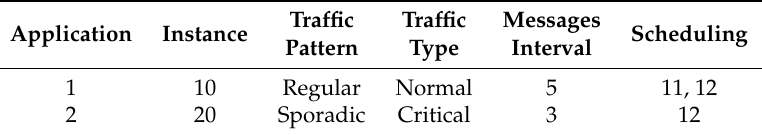
Table 7. Scheduling for DYNASTI for the No Variation approach.